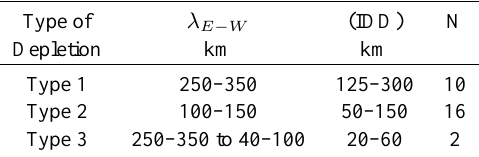
Fig. 7. Plasma depletions in the 630nm images taken over Kavalur on the night of 29/30 March 1998. The arrow points towards the geomagnetic north. Table 1. East–west scale ( λ E − W ), inter-depletion distance (IDD) and the total number of plasma depletions observed (N) in each category during eight nights of